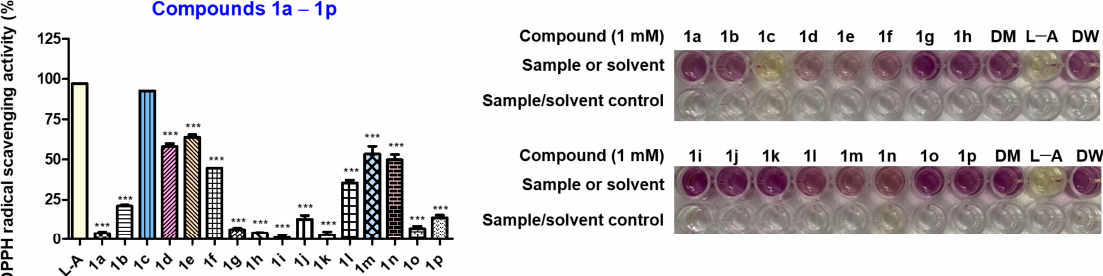
Figure 12. DPPH radical scavenging activities of compounds 1a – 1p . DPPH radical scavenging activities were assessed in 0.18 mM DPPH methanol solution in the presence of 1 mM of each compound or 1 mM of L -ascorbic acid ( L -A; the positive control). DMSO (DM) and distilled water (DW) were used as solvents for 1a – 1p and L -ascorbic acid, respectively. The symbol * indicates significant differences between columns: *** p < 0.001 for L -ascorbic acid versus the 15 compounds. Experiments were carried out independently three times.